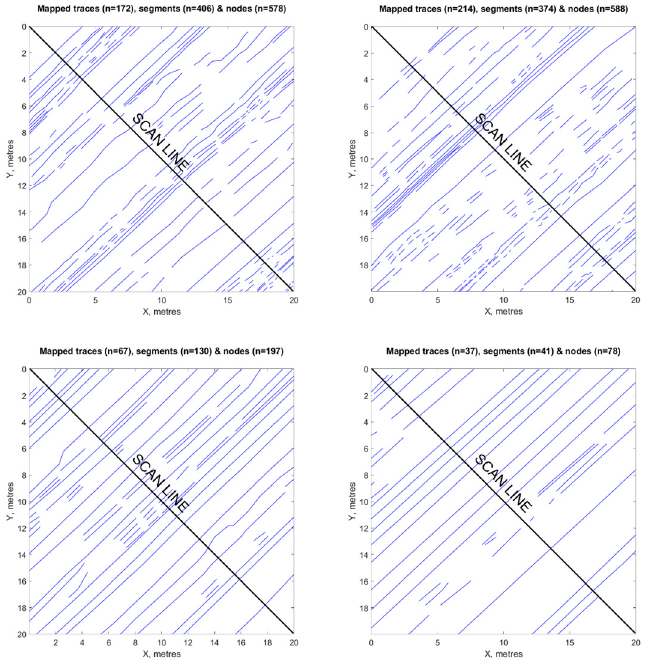
Figure 10. Bedding strata were manually traced from the orthomosaic within the box of each source sector. Table 3. Joint set normal mean spacings in the different source sectors.